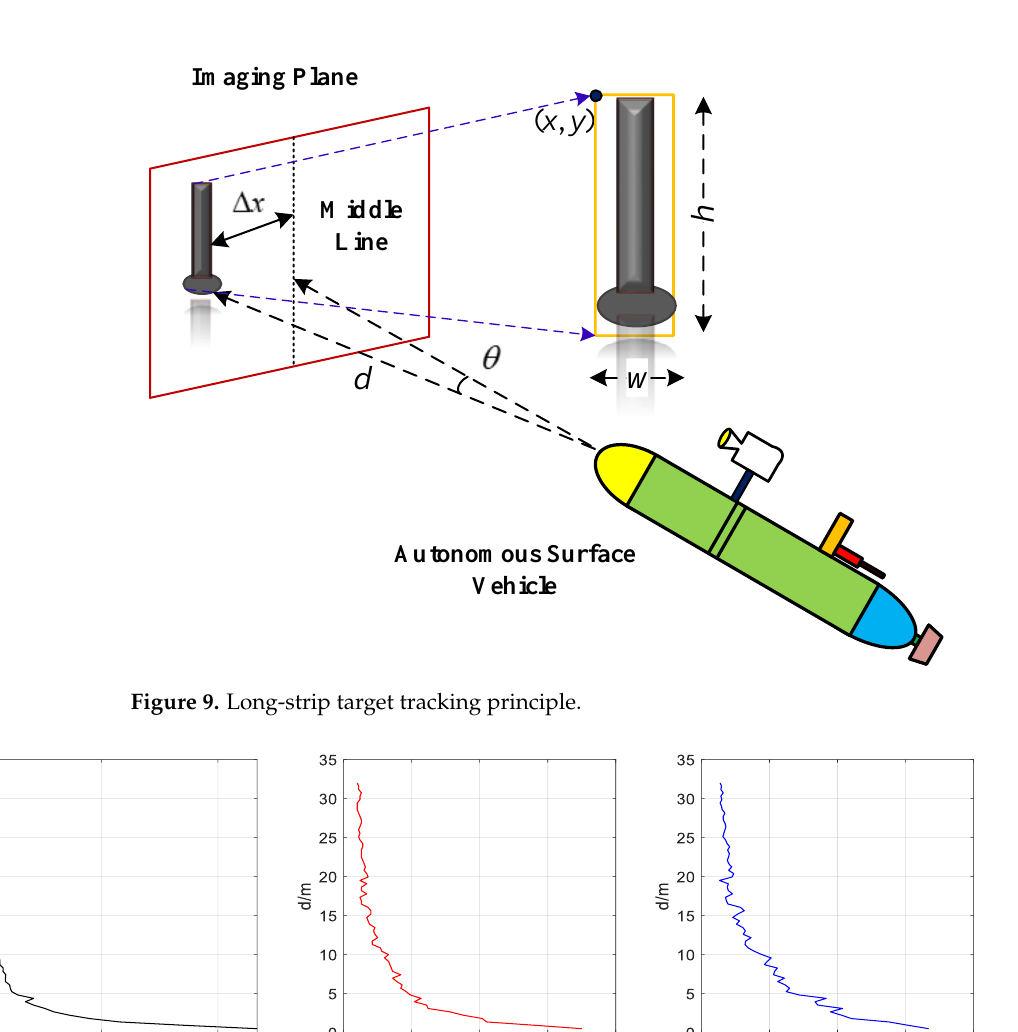
( d ) Figure 8. Target detection results with YOLOv3 and YOLO – Softer NMS:( a ) near case with YOLOv3,( b ) near case with YOLO – Softer NMS,( c ) far case with YOLOv3,( d ) far case with YO- LO – Softer NMS. 4. Target Tracking Model of Autonomous Surface Vehicle 4.1. Target DetectionMethod The long-strip target detection principle is describedin Figure 9.The waterproof camera can collect environmental images in front of the ASV. In the imaging model forthelong-strip target in Figure 9, coordinate point ( x , y )denotes the upper-left coordi- nate of target’s bounding box, w and h denote the width and length of bounding box, and x  is the pixel distance between the target and midline of the imaging plane. Thesquareof the yellow boundingbox s = w × h is derived from the YOLO-Softer NMS method.The vertical distance between the ASV and target imaging plane is d , and the de-